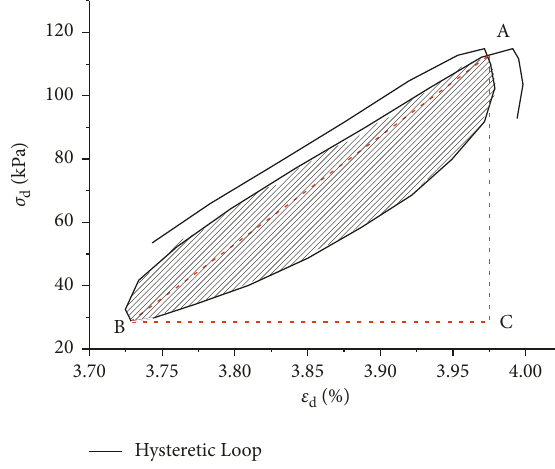
Figure 5: The hysteretic